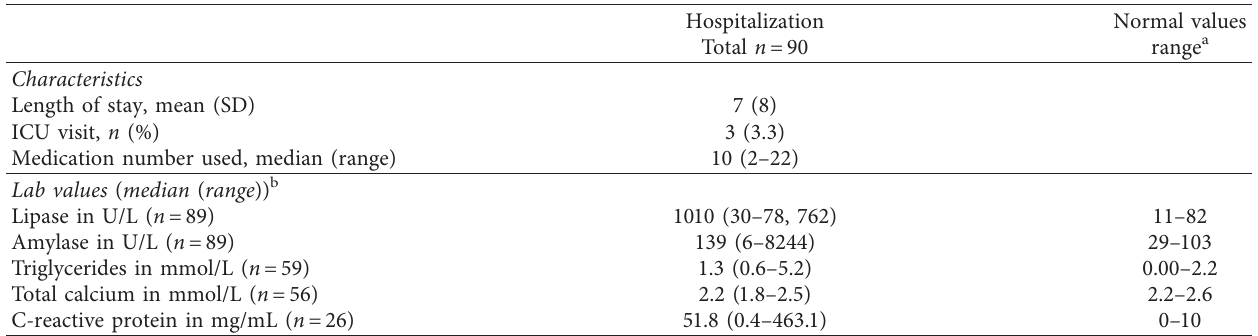
Table 2: Characteristics of drug-induced acute pancreatitis hospitalizations that occurred in the Saguenay-Lac-Saint-Jean hospitals. Hospitalization